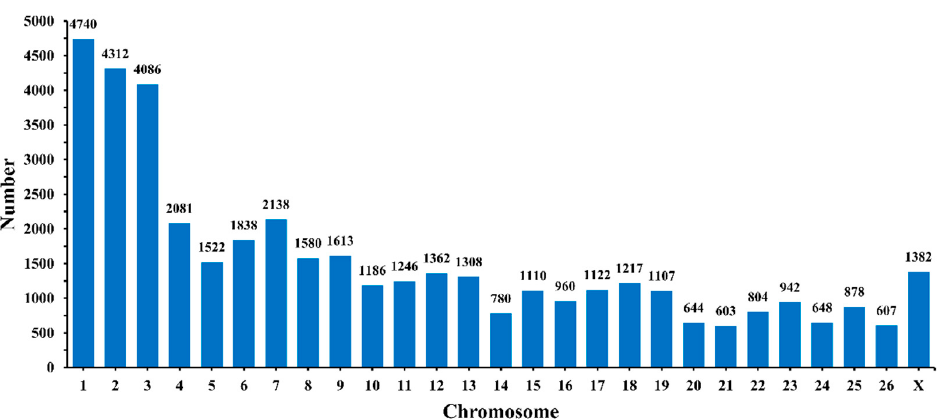
Figure 1. Chromosome distribution of circular RNAs identified from the hypothalami.